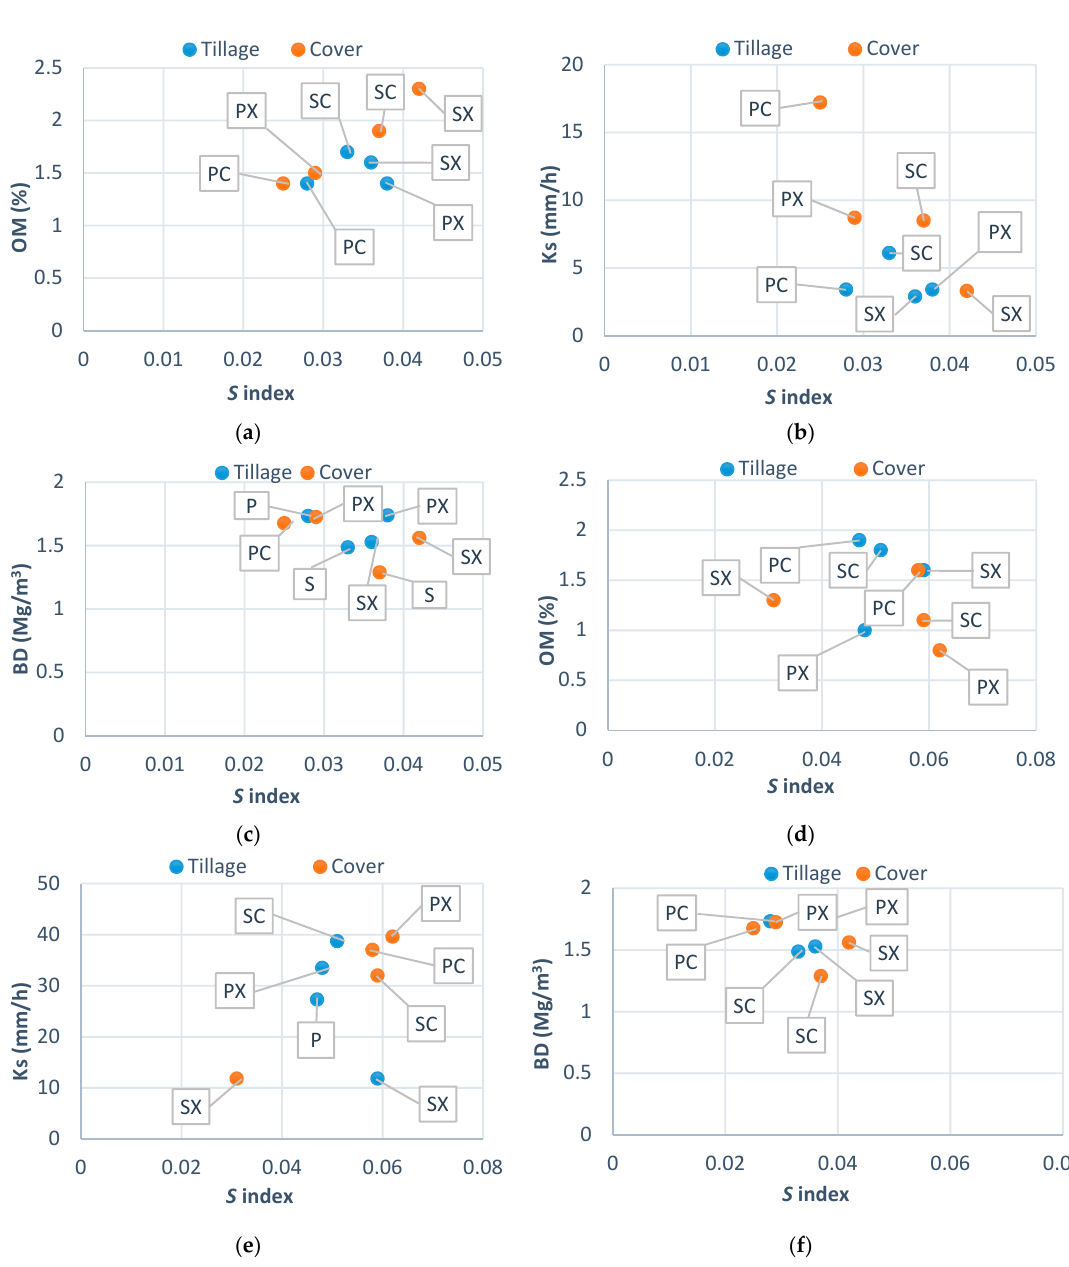
Figure 3. Comparison between the S index obtained with the mean WRC from the van Genutchen approach (X axis) and selected soil properties (Y axis): organic matter (OM), saturated hydraulic conductivity (Ks) and bulk density (BD) at Pedrera ( a – c ) and Bencazón ( d – f ). Blue and orange dots show Tillage and Cover managements, respectively, at the different areas: SX (0–10 cm inter tree row), PX (10–20 cm inter tree row), SC (0–10 cm under tree canopies) and PC (10–20 cm under tree canopies)